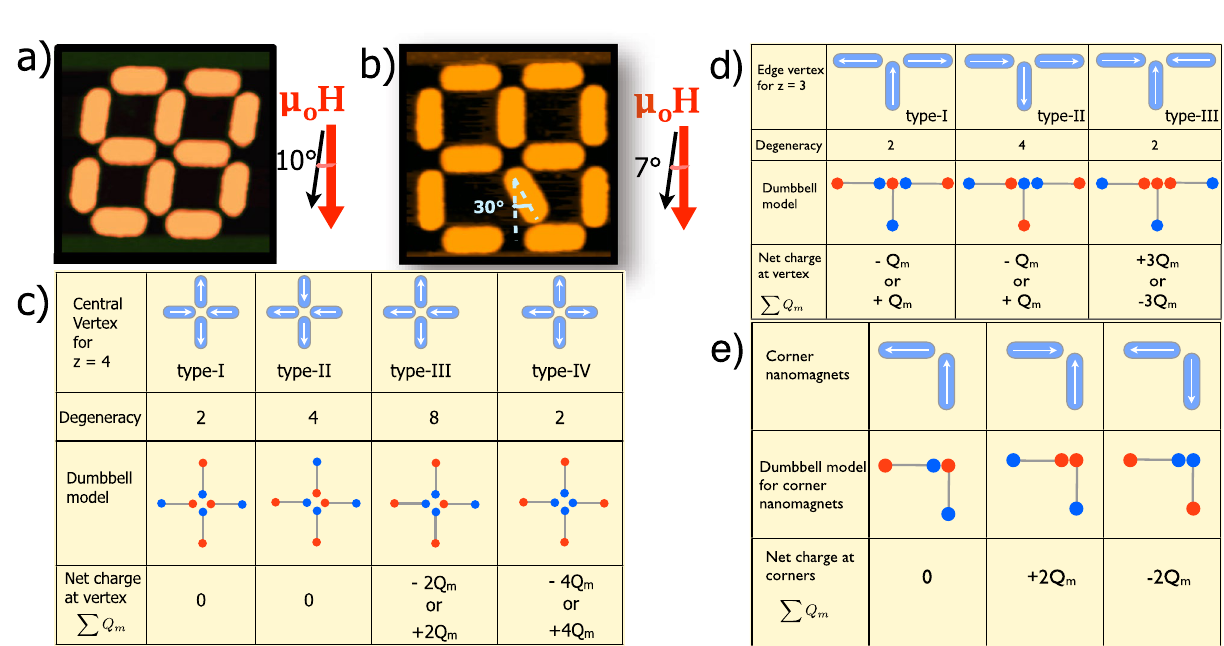
Figure 1. Topography images of ASI systems as well as schematics defining magnetic charges at border and central vertices. AFM images of square ASI vertices with closed edges resembling a stained glass window (a) and a deformed stained glass window (b) . The stadium shaped nanomagnets are of dimensions 300 × 100 × 25 nm and are magnetically in single domain state. In the deformed stained glass window, the misaligned nanomagnet is placed at 30 ◦ with respect to the long axis of the vertical nanomagnets. The applied magnetic field direction is at an angle of 10 ◦ and 7 ◦ with respect to the vertical nanomagnets for the window patterns (a,b) , respectively. (c) shows the possible vertex configurations for z = 4 vertex with nomenclatures of different types (type-I, type-II,...etc.) of spin ice vertices. Schematics of possible orientations of magnetization, magnetic charges in the nanomagnets under dumbbell model and net charges at edge vertices for z = 3 (d) and corners (e)